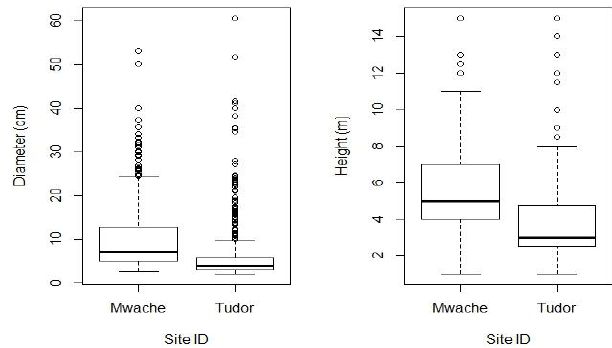
Fig. 2. Diameter and height distribution in Tudor and Mwache Figure 2: Diameter and height distribution in Tudor and Mwache creek 11 creeks.